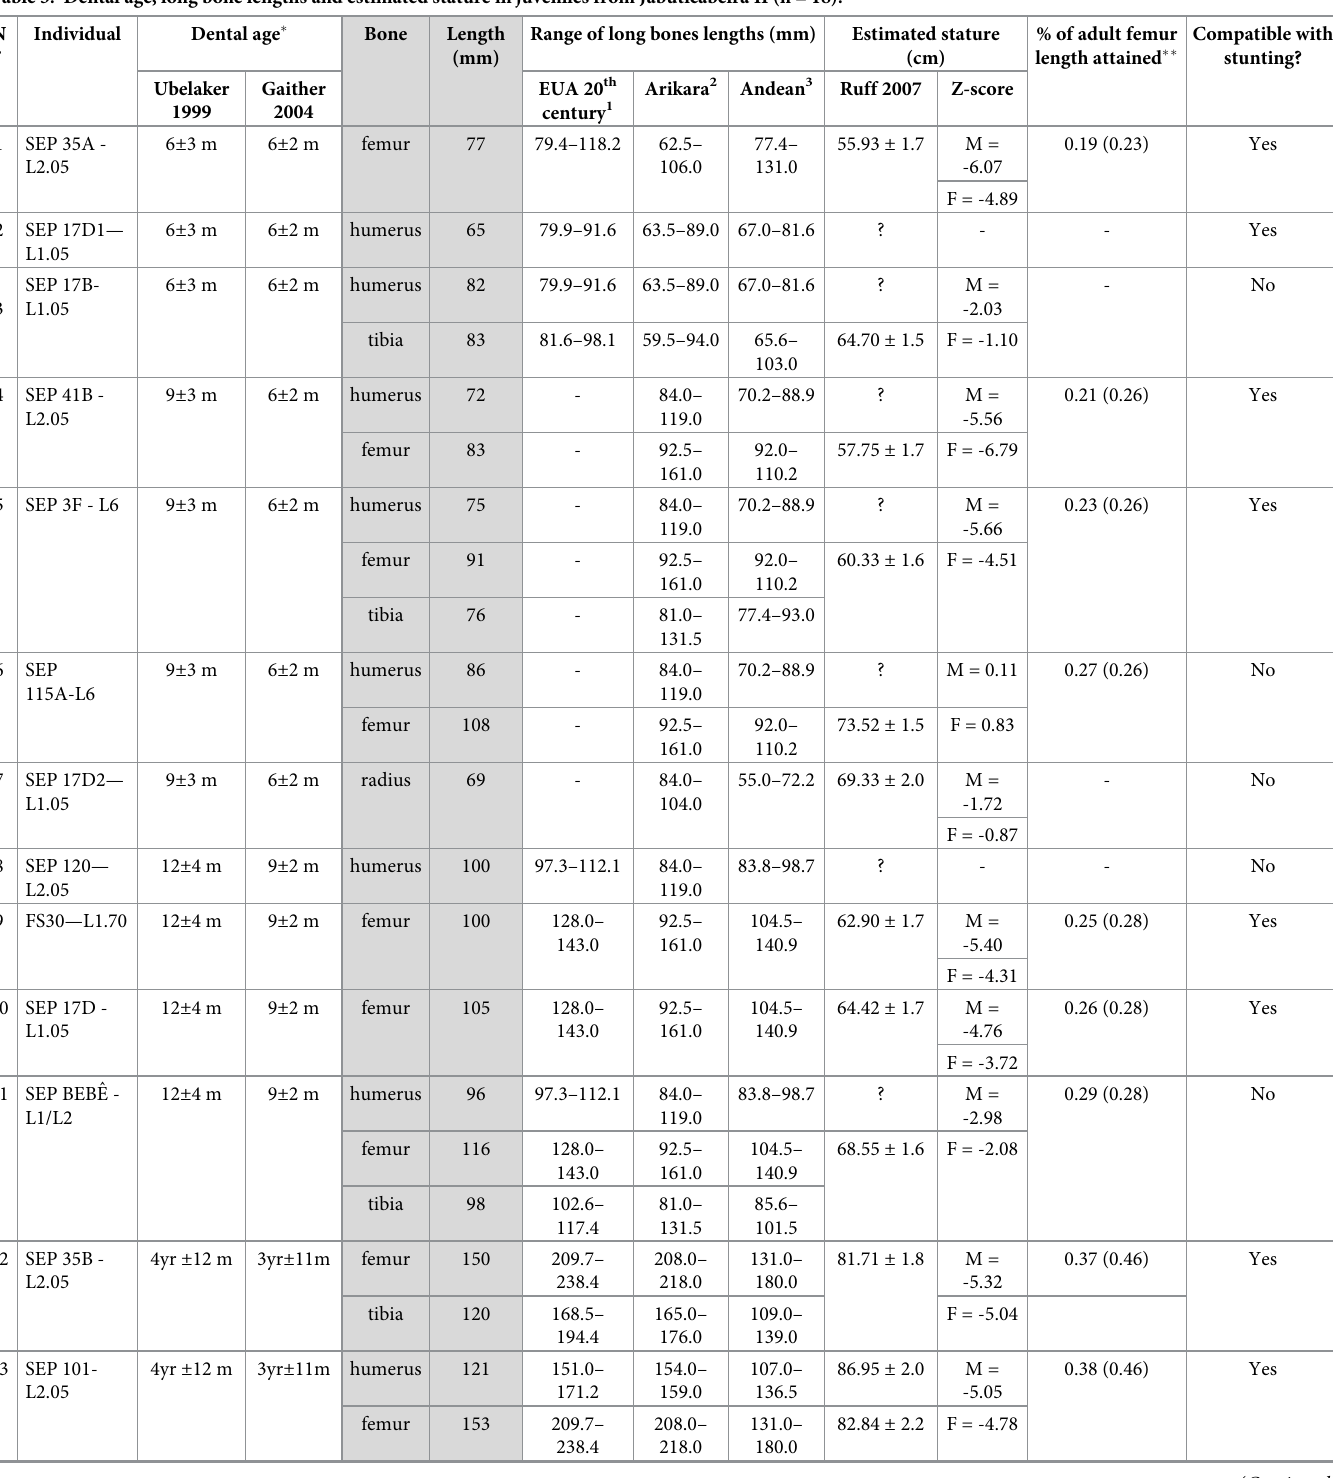
Table 3. Dental age, long bone lengths and estimated stature in juveniles from Jabuticabeira II (n = 18). N ˚